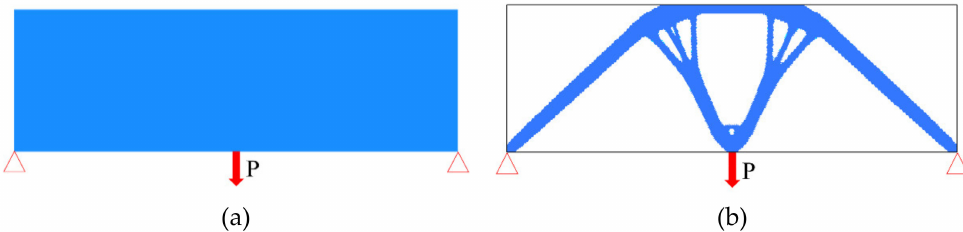
Figure 1. Illustration of topology optimization: ( a ) design area and boundary conditions; ( b ) result of the topology